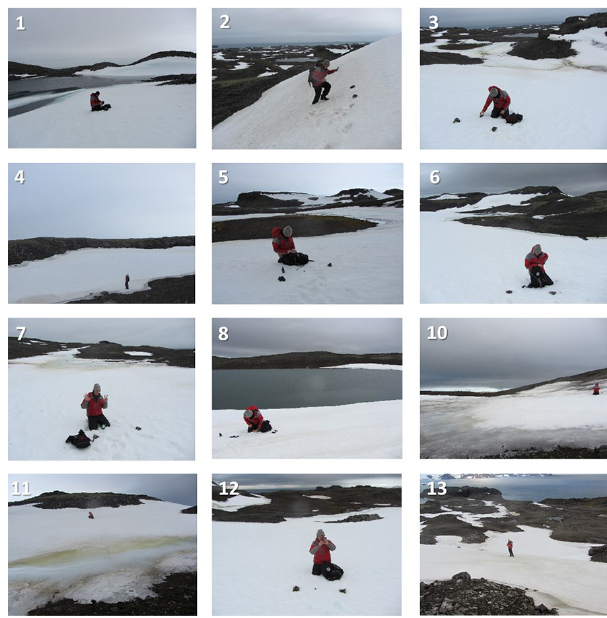
Figure 4. Overview of the snow conditions in the sampled snow patches during the field survey in the Meseta Norte in January